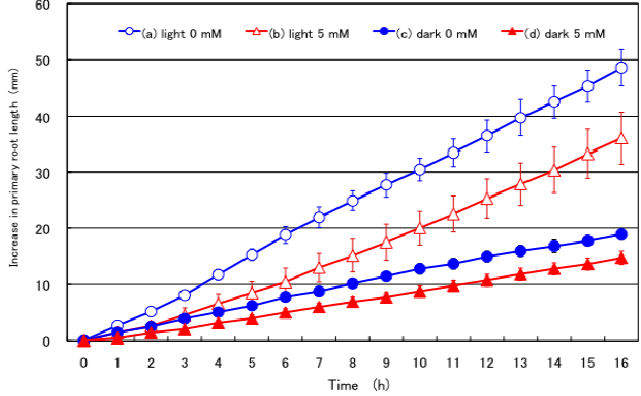
Figure 2. Effects of supplying 5 mM nitrate to the culture solution on the growth of the primary root under light or dark conditions. (a) Light 0 mM: Plants were cultivated with N free culture solution under light conditions at 28 °C; (b) Light 5 mM: Plants were cultivated in the culture solution with 5 mM nitrate under light conditions at 28 °C; (c) Dark 0 mM: Plants were cultivated with N free culture solution under dark conditions at 18 °C; (d) Dark 5 mM: Plants were cultivated in the culture solution with 5 mM nitrate under dark conditions at 18 °C. The graph shows increases in the length of the primary root. Each data point shows the average and standard error of four replications of each treatment. The primary root growth was statistically different ( p < 0.01) compared with light 0 mM treatment by T -test from 2 h in dark 0 mM, and from 2 h in dark 5 mM treatment. Statistical difference ( p < 0.05) was observed from 5 to 8 h in light 5 mM nitrate